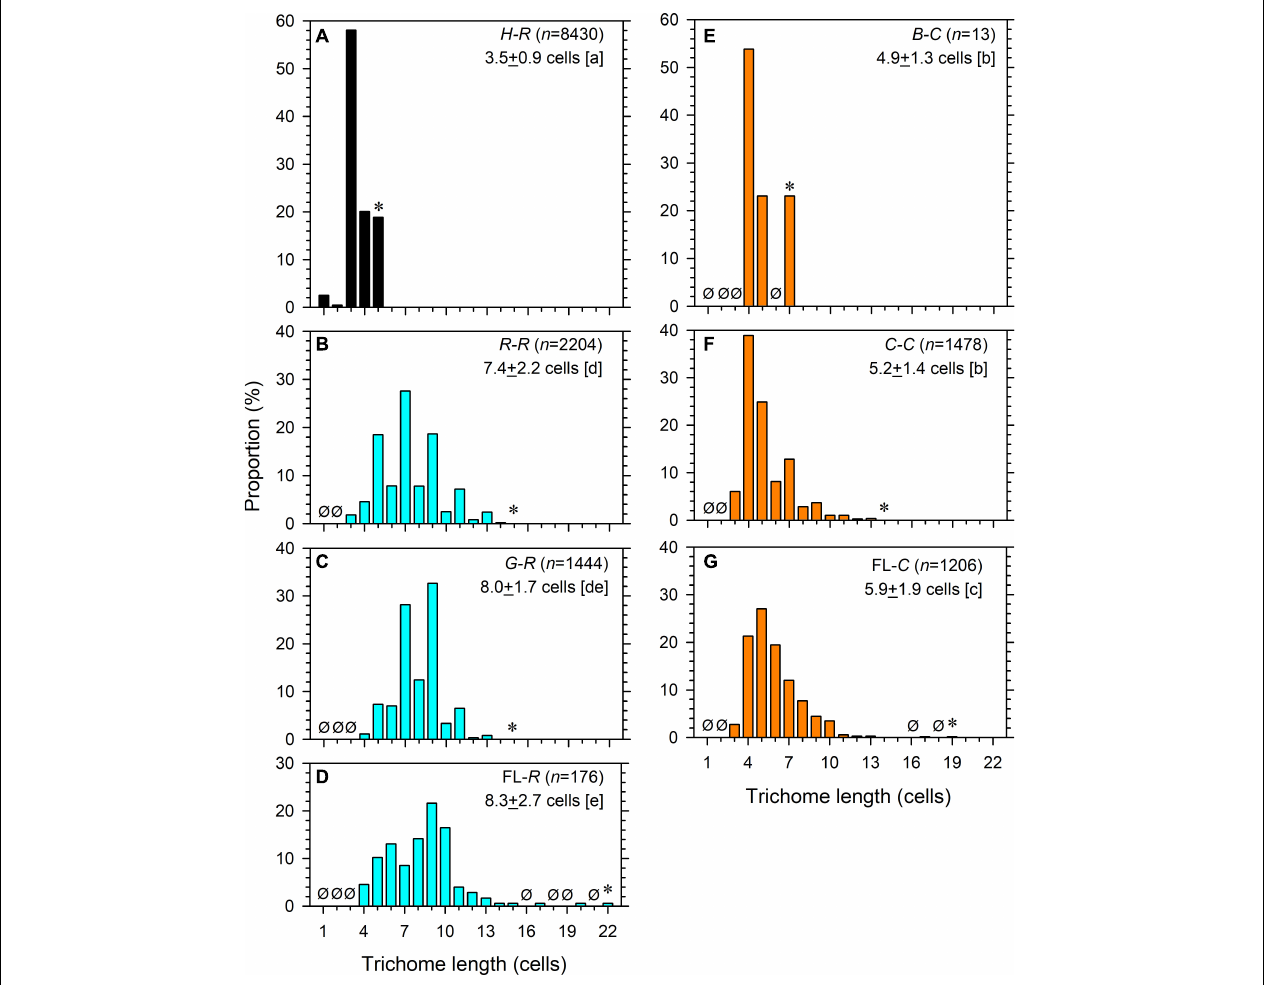
FIGURE 2 | Trichome lengths of (A) internal and (B,C) partial symbionts Richelia and (D) free-living Richelia , as well as (E,F) external symbionts Calothrix and (G) free-living Calothrix . Ø indicates none observed at the length. Asterisk indicates the maximal length observed. n , number of filaments examined. The mean ± 1 standard deviation of length is noted. Different lowercase letters in the brackets refer to significant difference ( p < 0.05) of the mean after ANOVA ( F 6 , 14 , 944 = 3,645, p < 0.0001) and Tukey-Kramer